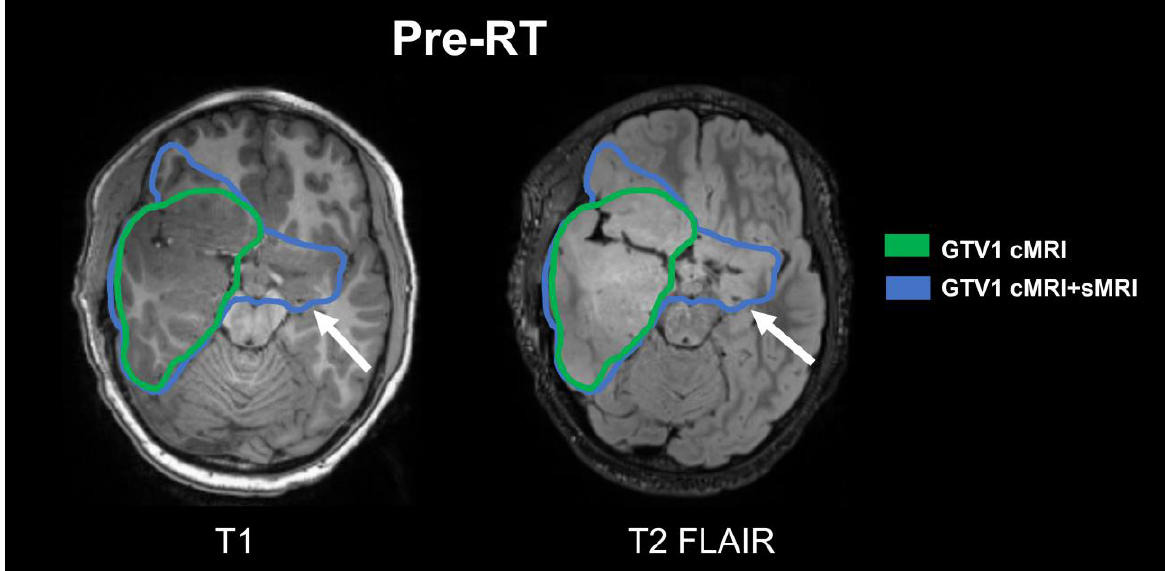
Figure 2. Comparison of GTV1 contours. Target volumes based on cMRI alone (green) and cMRI + sMRI (blue) are shown overlaid on axial slices of the T1 ( left ) and T2 FLAIR ( right ) images. The sMRI detected an additional lesion in the left temporal lobe which is non-hyperintense on FLAIR and absent on the T1 imaging as well (white arrow). The volume of GTV1 cMRI was 207.61 cc compared to the GTV1 cMRI + sMRI volume of 297.84 cc.